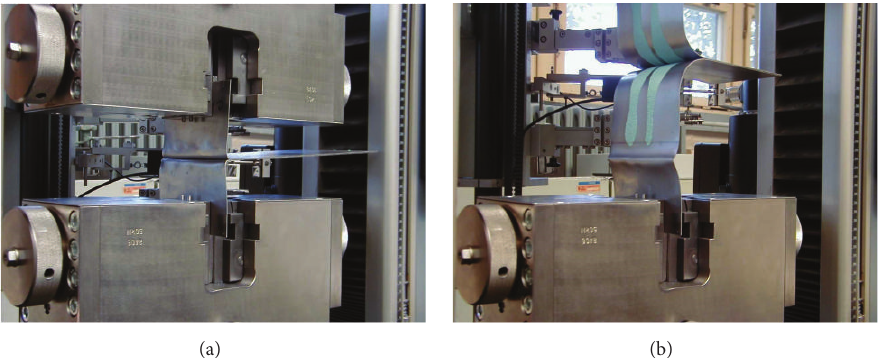
Figure 10: View on peel test of bonded joints (a) before peeling and (b) during